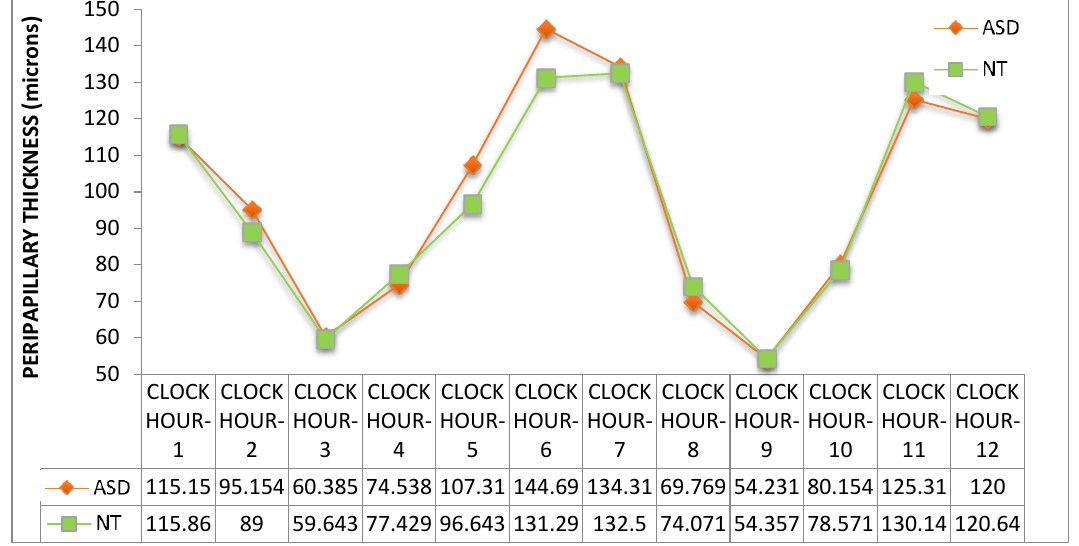
Figure 7. Peripapillary retinal nerve fiber layer thickness of the 12 clock-hour sectors. ASD = autism spectrum disorder group; NT = neurotypical group. Values represent mean thickness in microns for each group. No significant differences were detected between groups (Mann–Whitney U test).